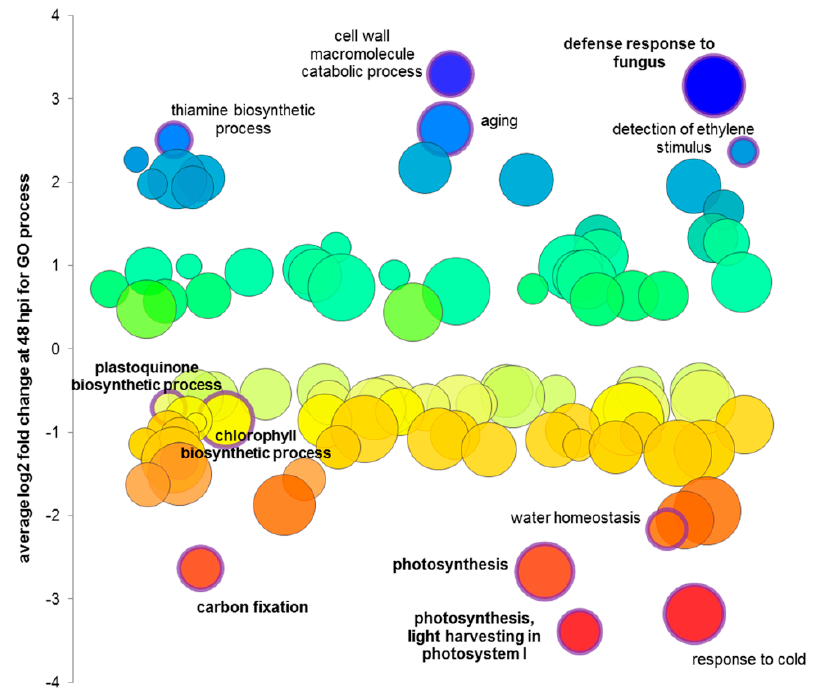
Figure 7. Gene Ontology of Biological Processes in B. oleracea leaves during A. brassicicola infection.